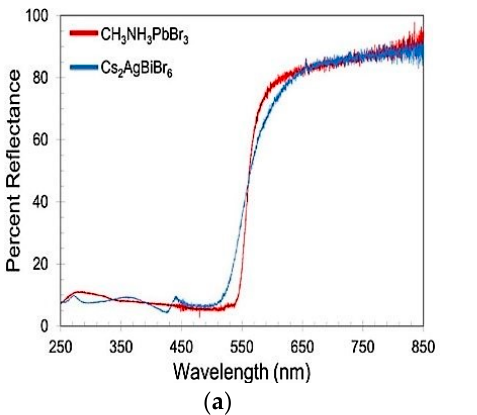
6 of 17 Figure 4. Measured powder XRD pattern for Cs 2 InAgCl 6 ( top ), and the XRD pattern calculated from the atomistic model optimized using density functional theory/local density approximation (DFT/LDA) ( bottom ). Reproduced with permission from Reference [31]. American Chemical Society, 2017. Hybrid lead halide perovskites have shown remarkable photovoltaic performance when used in PSCs. Various structural dimensions, such as two-dimensional (2D) and 3D, of these hybrid lead halide perovskites have been explored as light absorbers in PSCs. The 3D structures of these perovskites have shown a better photovoltaic performance, which is ideal for single junction solar cell applications [42,43]. Most studied halide double perovskites exhibited 3D structures; however, their bandgaps were very wide, which means that the photovoltaic performance of these perovskites is not only dependent on structural dimensionality. Xiao et al. [43] introduced the concept of electronic dimensionality to help explain why the 3D halide double perovskites do not exhibit ideal photovoltaic performance as their 3D hybrid halide perovskites counterparts do. Electronic dimensionality is the connectivity of lower conduction band and upper valence band atomic orbitals. High electronic dimensionality is needed for perovskites to exhibit good photovoltaic performance. Even though the halide double perovskites crystallize into 3D structural dimension, they might exhibit low electronic dimensionality, rendering them unsuitable for single junction solar cell application. 4. Optical